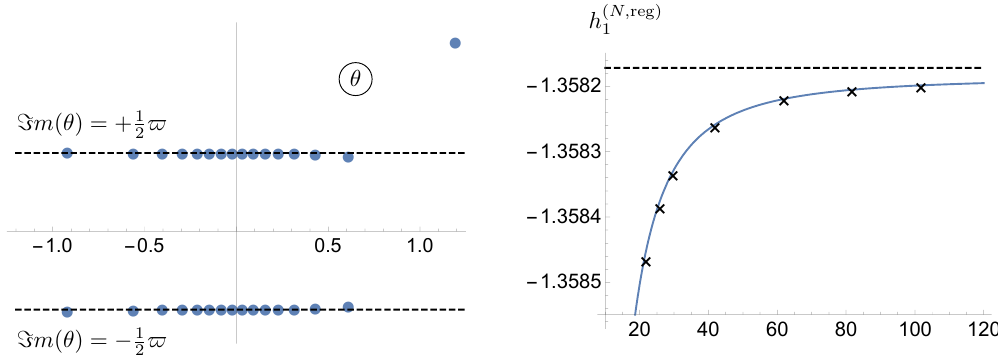
(cid:0) θ = (cid:0) ¯ (cid:1) P (vac) ⊗ NS . The 2 (cid:0) (cid:1) cos( $ ) = N − (1 − β 2 ) h ( N ) − N . The crosses were 1 1 2 sin( πβ 2 / 2) to the eigenvalue 1 (cid:0) (cid:1) P (vac) . This eigenvalue is not available 2 , 0 NS leads to the 2 , 0